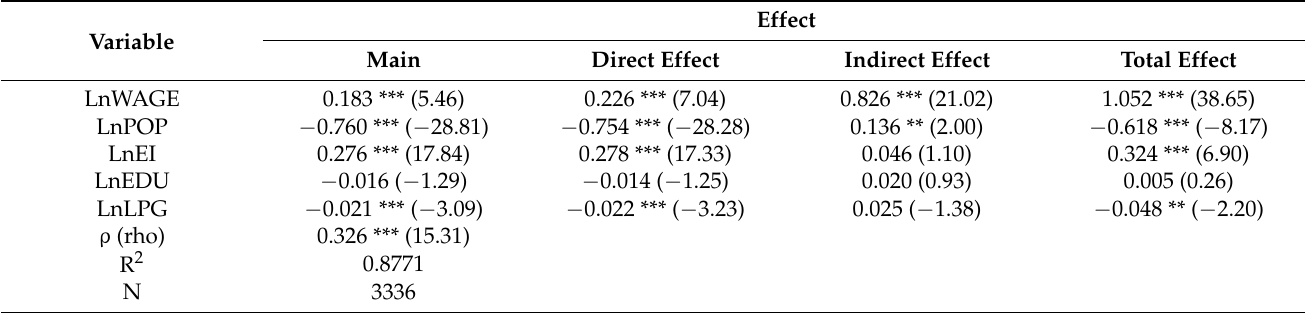
Table 12. Regression results of SDM under the